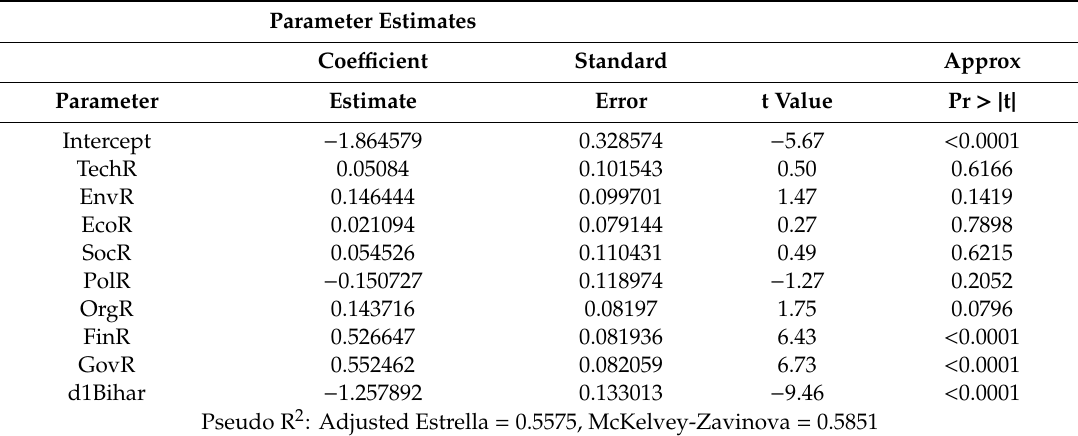
Table 15. Ordered probit regression results—rationalities and financial performance. Parameter Estimates Coe ffi cient Standard Approx Parameter